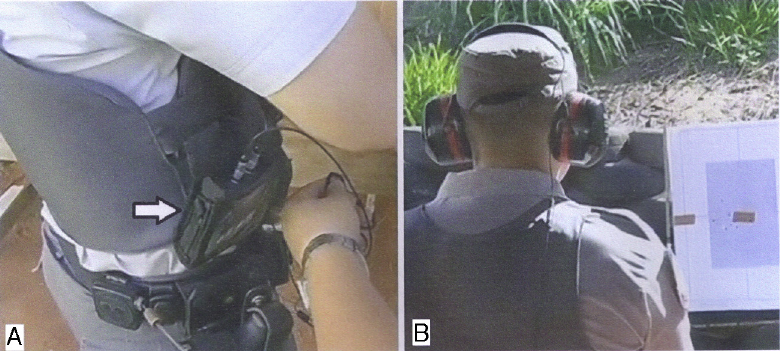
(A) Photograph showing audiodosimeter attached to police officer’s vest (arrow); and (B) use of clamshell ear protector during training session in the shooting range.